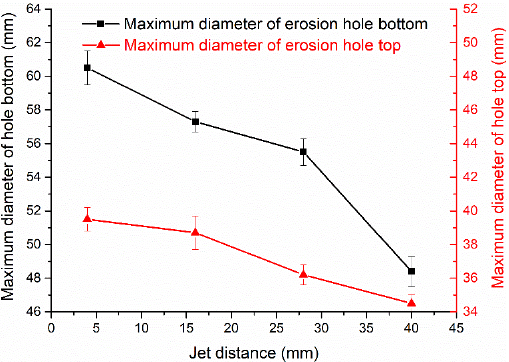
Figure 7. The influence of jet distance on the maximum diameter of the erosion ‐ hole top and the maximum diameter of the erosion ‐ hole bottom.